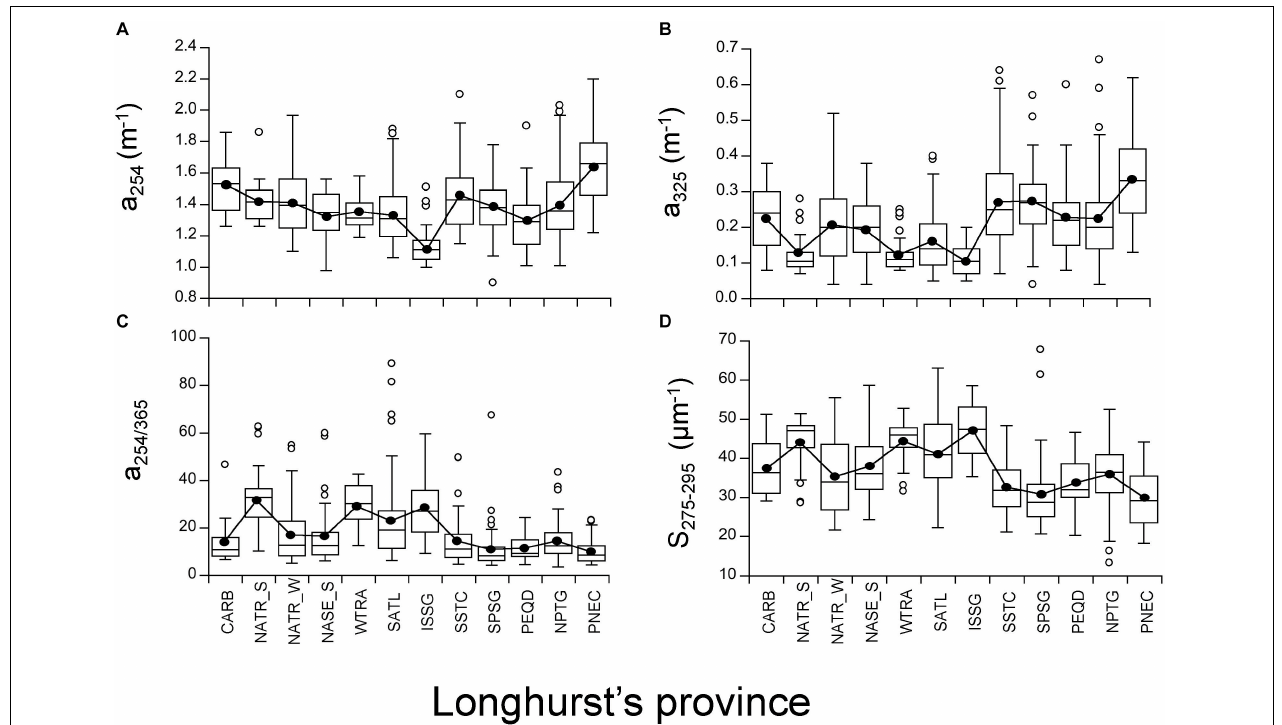
FIGURE 7 | Box and Whisker plots for the four explained optical variables at each biogeographic province. Horizontal line represents median; black circles represent means; white-box represent 25–75% percentiles and whiskers extend from the upper (lower) to the highest (lowest) value that is within 1.5x inter-quartile range of the hinge. Solid black line connects all mean values for each province among the oceans. (A) a 254 , (B) a 325 , (C) a 254 / 365 , and (D) S 275 − 295